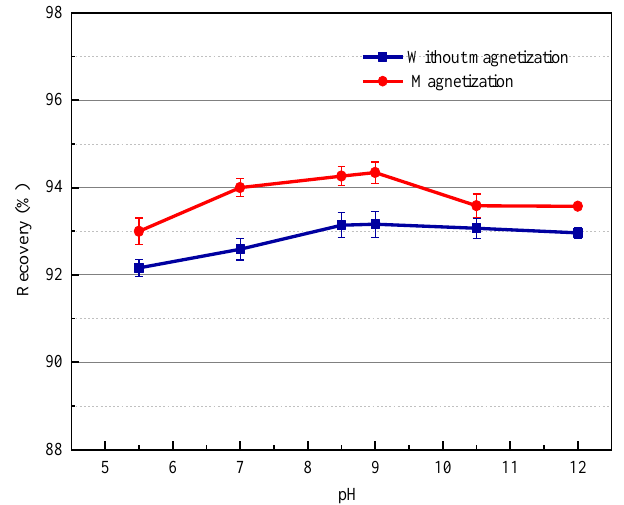
Figure 7. The relationship between pH and the recovery of chalcopyrite.